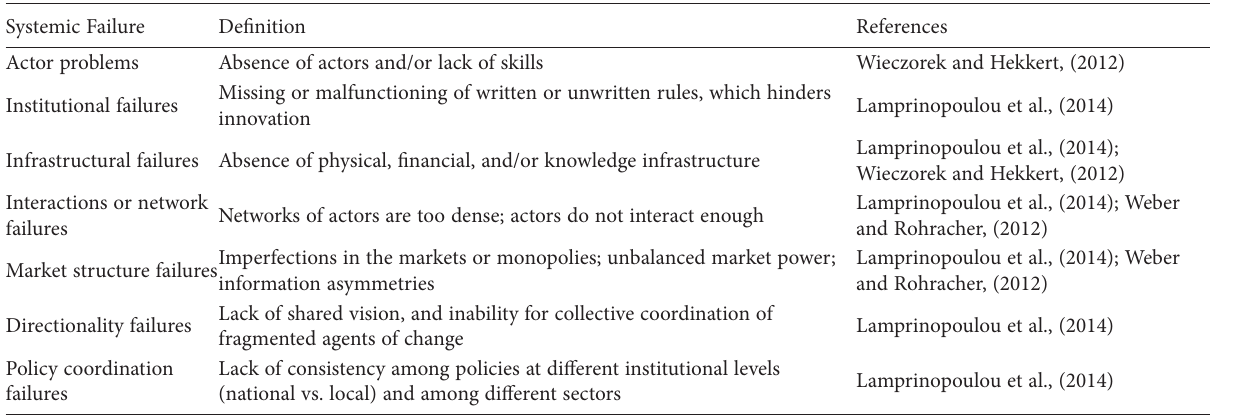
Table 2. Description of the systemic failures selected from the